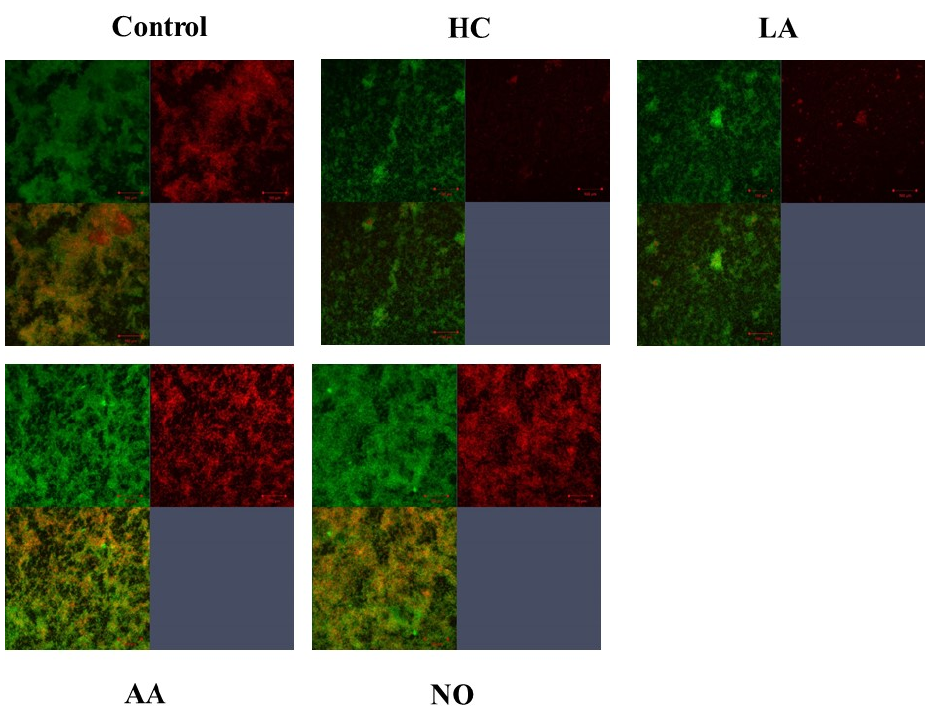
Figure 4. Confirmation of Gtfs on the MVs in the various conditions. To confirm glucan synthesis in biofilm formation induced by MVs that were extracted in control, HC, LA, AA and NO conditions, their biofilms were stained by SYTO 9 and Alexa Flour 647-dextran conjugate, observed by confocal microscope and analyzed by Zen. Upper left: live cells, upper right: glucan, and lower left: live cell merged with glucan were presented. Representative data from more than three independent experiments were presented in the pictures.